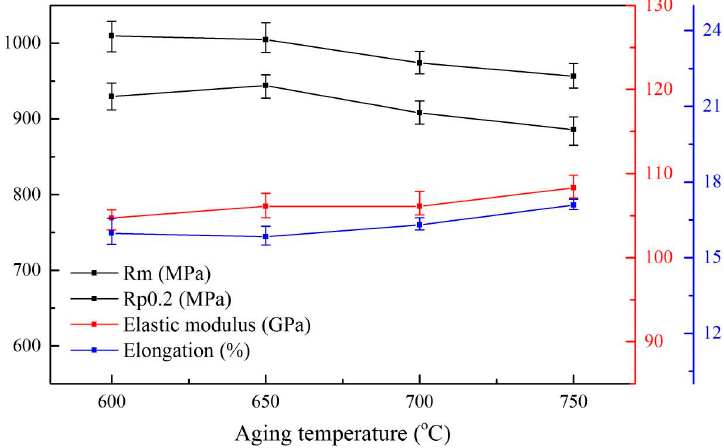
Figure 11. Mechanical properties of microstructures obtained by different aging treatments.